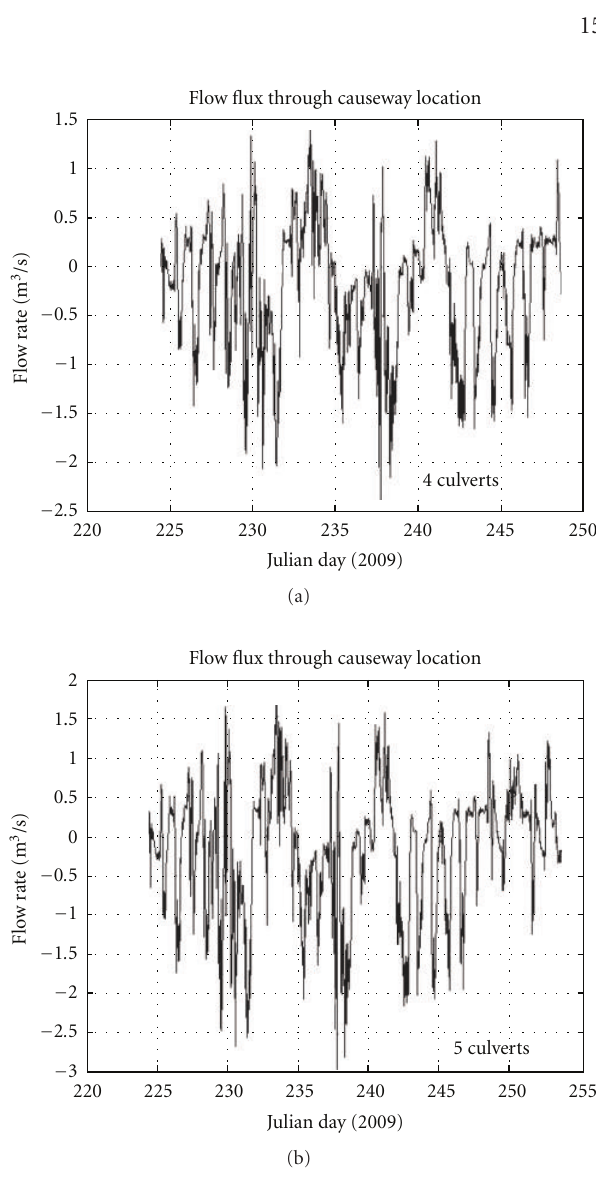
Figure 22: The flow rates of the passing through the causeway, driven by natural wind and under the causeway configuration of 4 and 5